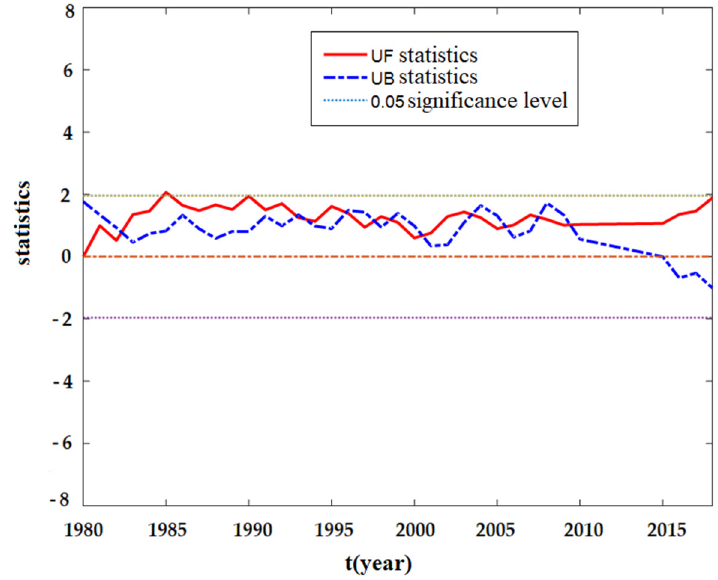
Figure 8. Trend of M-K statistics of Figure 8 Trend of M-K statistics of precipitation